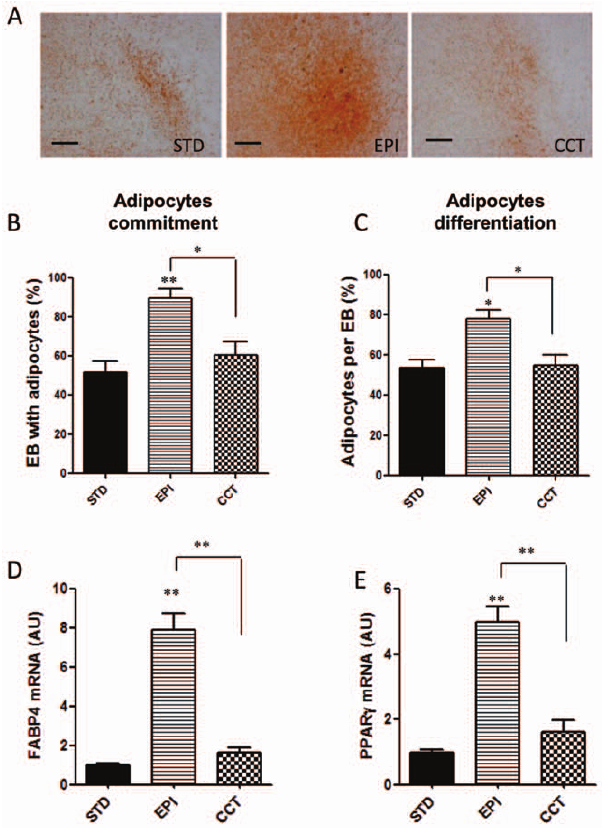
Figure 5. Epinephrine-induced adipogenesis is mediated by the NPY system. (A) EBs were treated with insulin (STD), insulin plus epinephrine (EPI) or insulin plus EPI and NPY receptors antagonists (CCT) from day 7 to day 17.Final differentiated adipocytes were detected by oil red O-staining. Scale bars=150 m m. (B) Percentage of EB outgrowths with adipocyte colonies and (C) percentage of adipocytes per EB outgrowth were measured and quantified at day 27. (D–E) mRNA levels of adipocyte markers were measured by RT-PCR at the end of the differentiation. RNA was isolated from differentiated mESCs at day 27, and analyzed for expression of adipocyte marker genes FABP4 (D) and PPAR c (E). b -actin expression was used as an internal control. Values are from three separate experiments each perfoemed in triplicate *p , 0.05, **p , 0.01.